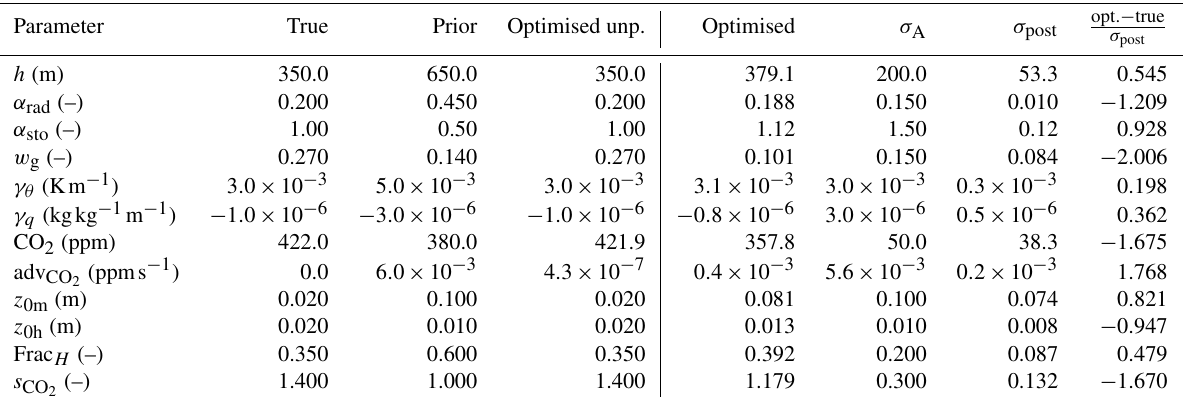
Table 4. Parameter values for the bias correction OSSEs. The used observation streams are q , h , H , LE , T 2 , F CO σ post are, respectively, the prior and posterior standard deviation of the state parameters. The rightmost column lists the optimised parameter value minus the true value, normalised with the posterior standard deviation of the respective parameter. The column Optimised unp. lists the optimised parameter values of the experiment without any perturbed observations. The four columns at the right-hand side only apply to the OSSE with perturbed observations. See Table A1 for a description of the parameters and Table A2 for a description of the observation streams.